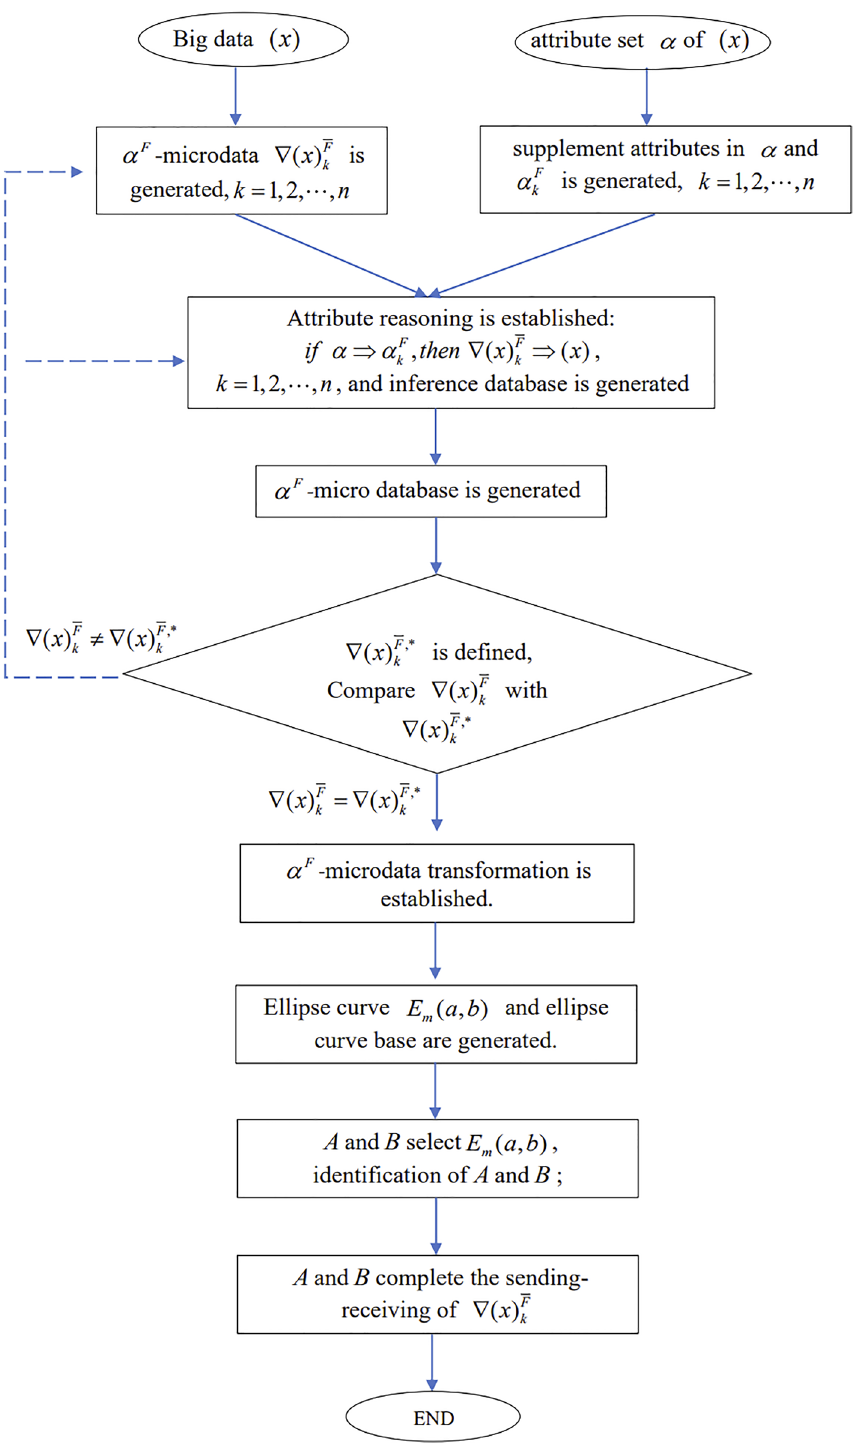
F Figure 2. α -microdata intelligent-security acquisition